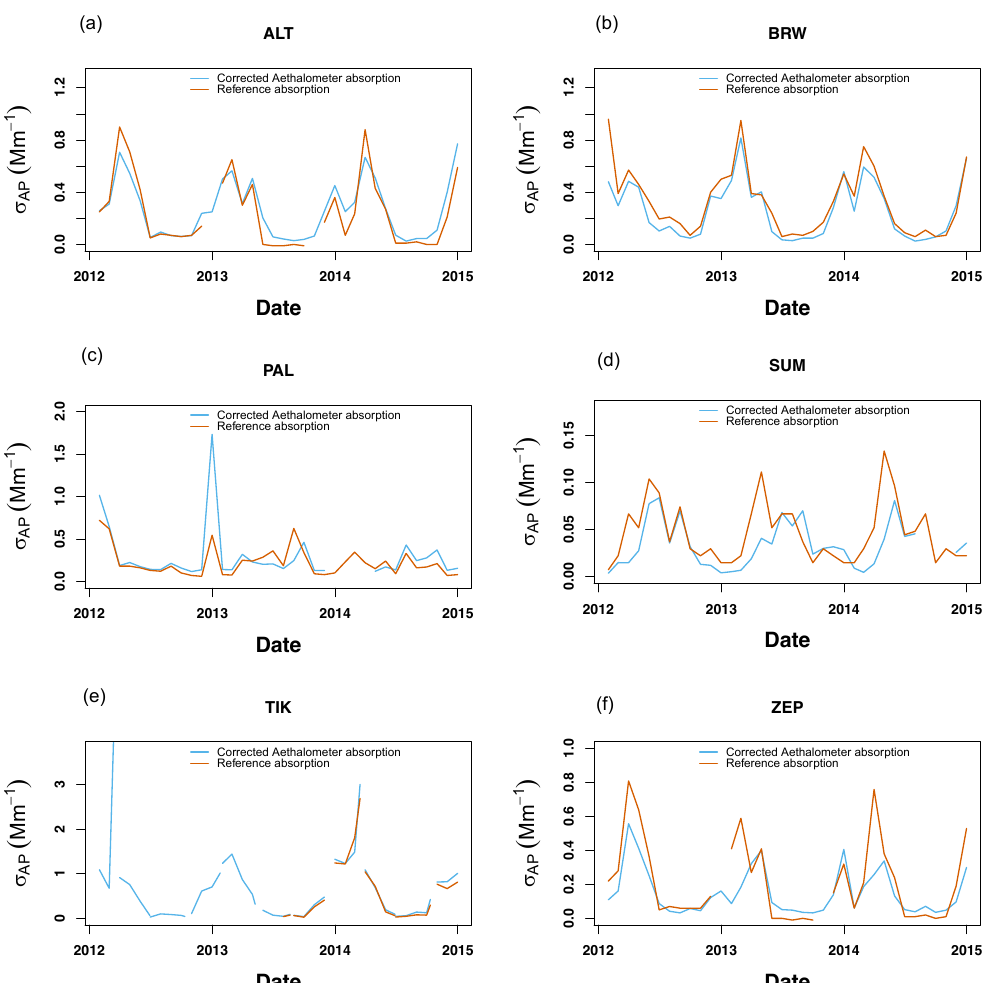
Figure 2. Comparison of monthly medians (computed from hourly data) and corrected Aethalometer absorption (light blue) and absorption measured by co-located absorption instrument (orange). (a) ALT absorption at 467nm, (b) BRW absorption at 467nm, (c) PAL absorption at 637nm, (d) SUM absorption at 880nm, (e) TIK absorption at 637nm, (f) ZEP absorption at 525nm. All data are at wavelength of co-located absorption instrument (PSAP, CLAP, or MAAP) except for SUM, where data are at wavelength of the one-wavelength AE16 Aethalometer (880nm). Note that y axes are different on each